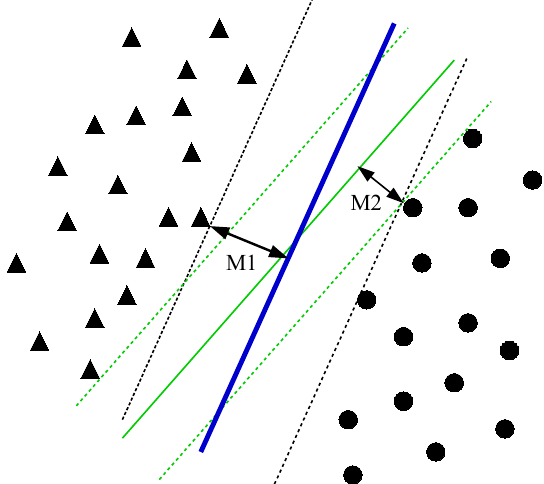
Figure 3. An illustration of a hyperplane that is created using a standard Support Vector Machine (SVM) for a sample dataset. Here, the green coloured hyperplane margin M 2 is smaller than margin M 1, which corresponds to the hyperplane in colour blue